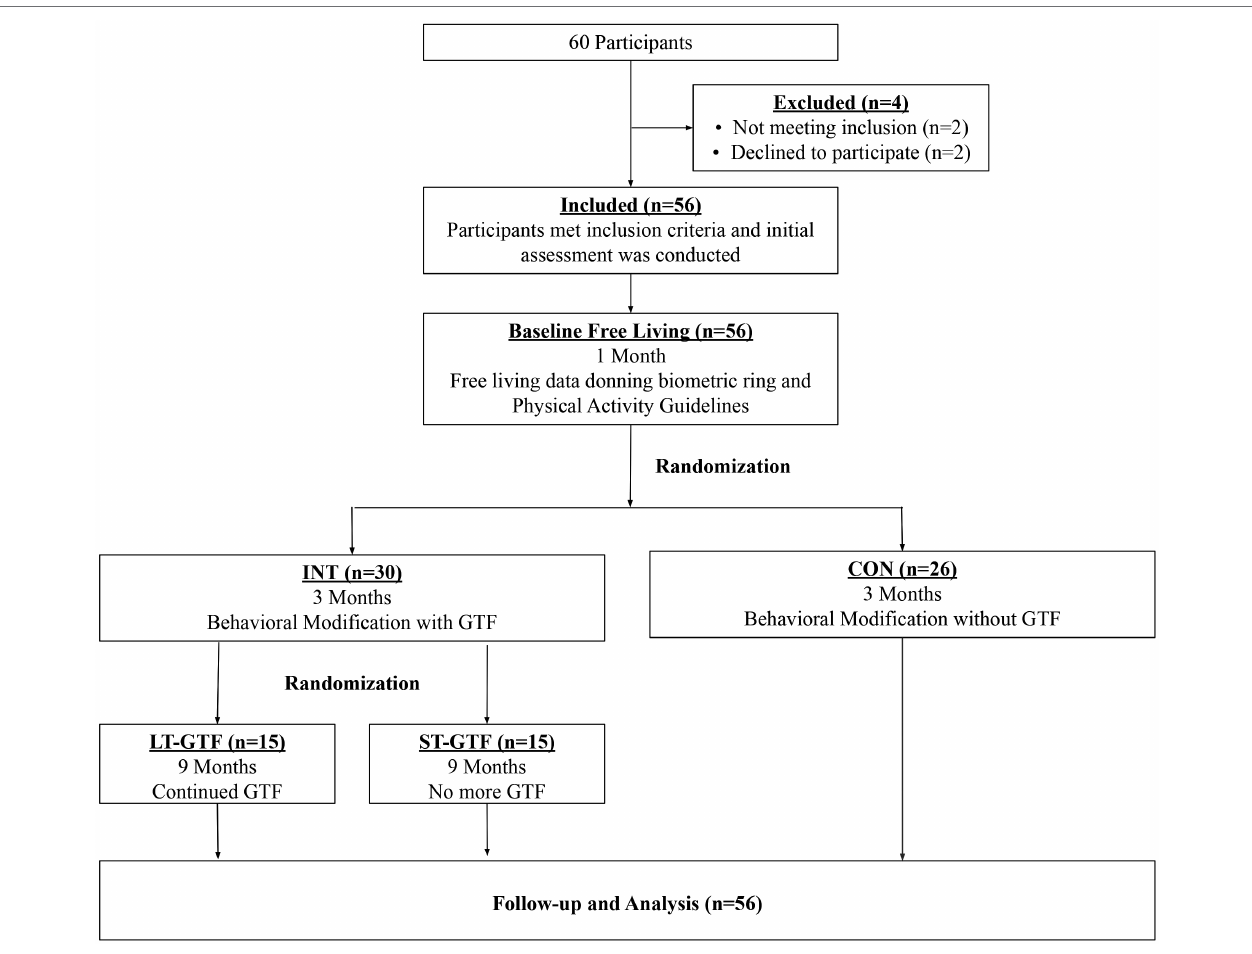
FIGURE 1 | CONSORT diagram showing participant flow through the study. INT, Intervention; CON, Control; GTF, Guided Text Feedback; LT-GTF, Long-Term GTF; ST-GTF, Short-Term